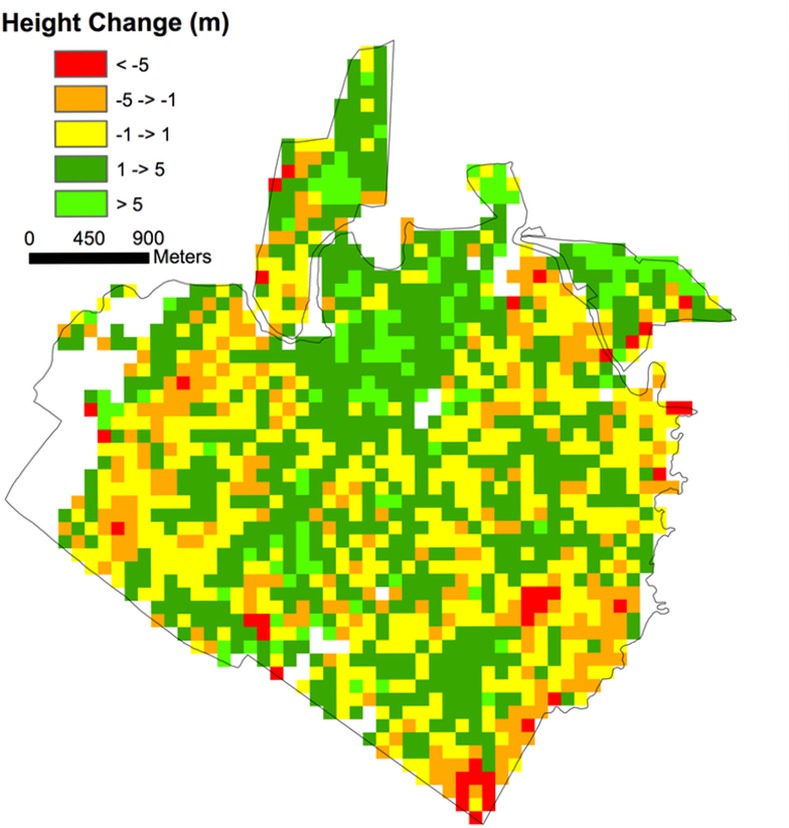
LVIS mean canopy top height change (2005–1998) at 1 ha.Mean canopy height change was determined by differencing elevation of the canopy top in 1998 and 2005 (ΔCTH, see Dubayah et al. 2010).